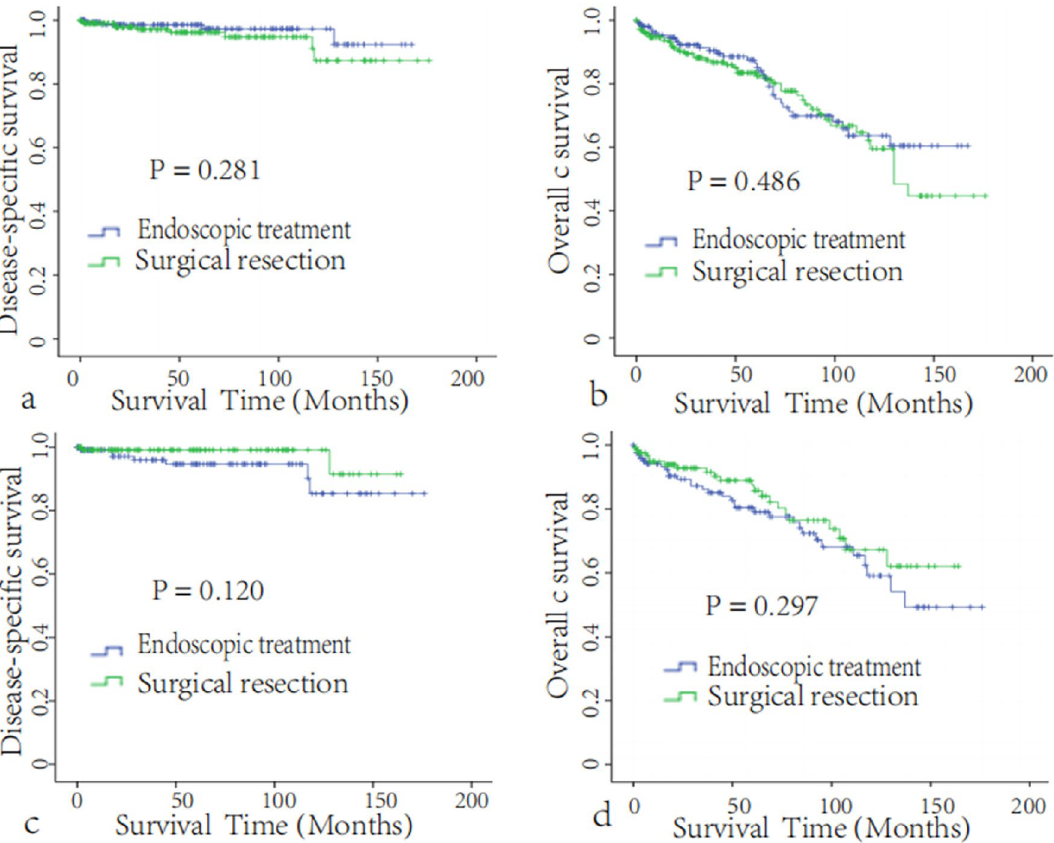
Figure 2. Disease-specific survival ( a ) and overall survival ( b ) of the endoscopic treatment group and surgical resection group before PSM (n = 373); disease-specific survival ( c ) and overall survival ( d ) of the endoscopic treatment group and surgical resection group after PSM (n =